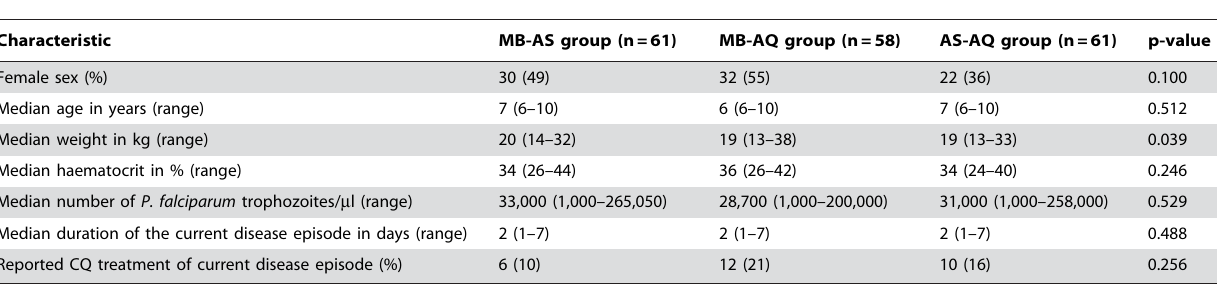
Table 1. Characteristics of study children at enrolment